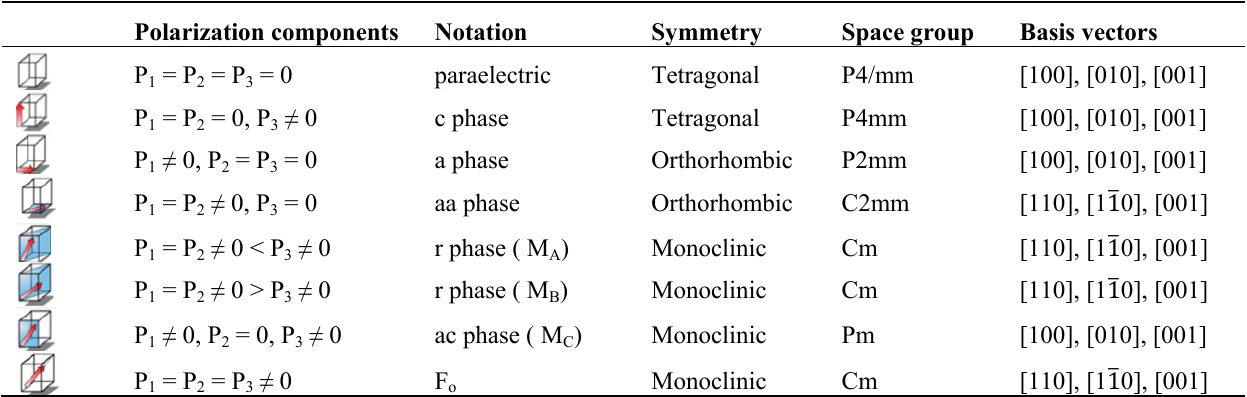
Table 1. Schematic representation, polarization components, notations, symmetry, space group and basis vectors in the mono-domain phase model. (Adapted with permission from [24], Copyright 2009